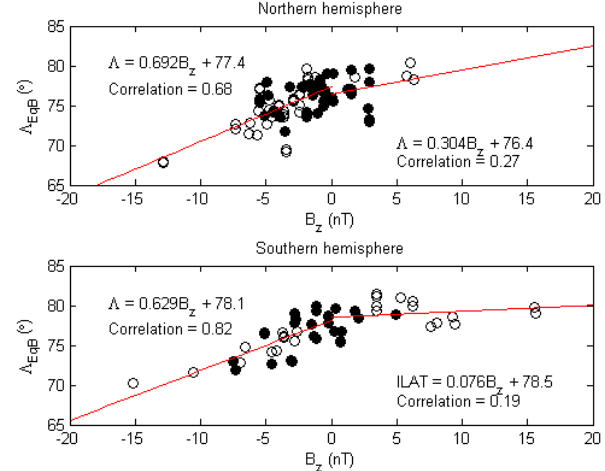
Fig. 9. Location of the equatorward (top) and poleward (bottom) cusp boundary as a function of the Z-component of the IMF. Only cases occurring under stable IMF conditions and for a solar wind dynamic pressure smaller than 5nPa are plotted.